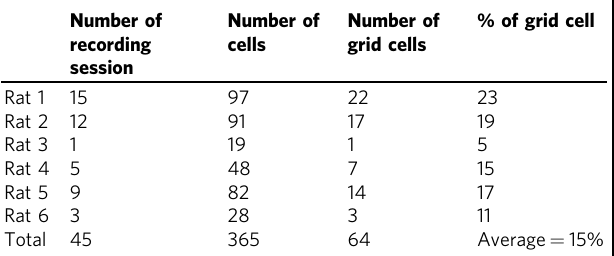
Table 1 Summary of the cell distribution Table 2 Summary of behavior in the circular track